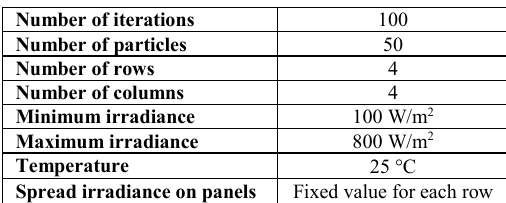
P ARAMETERS FOR S